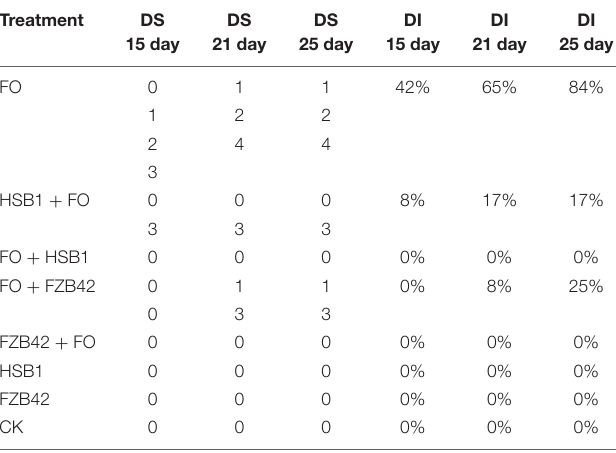
TABLE 1 | Disease severity (DS) scores and averaged percentages of disease incidence (DI) observed with each treatment.